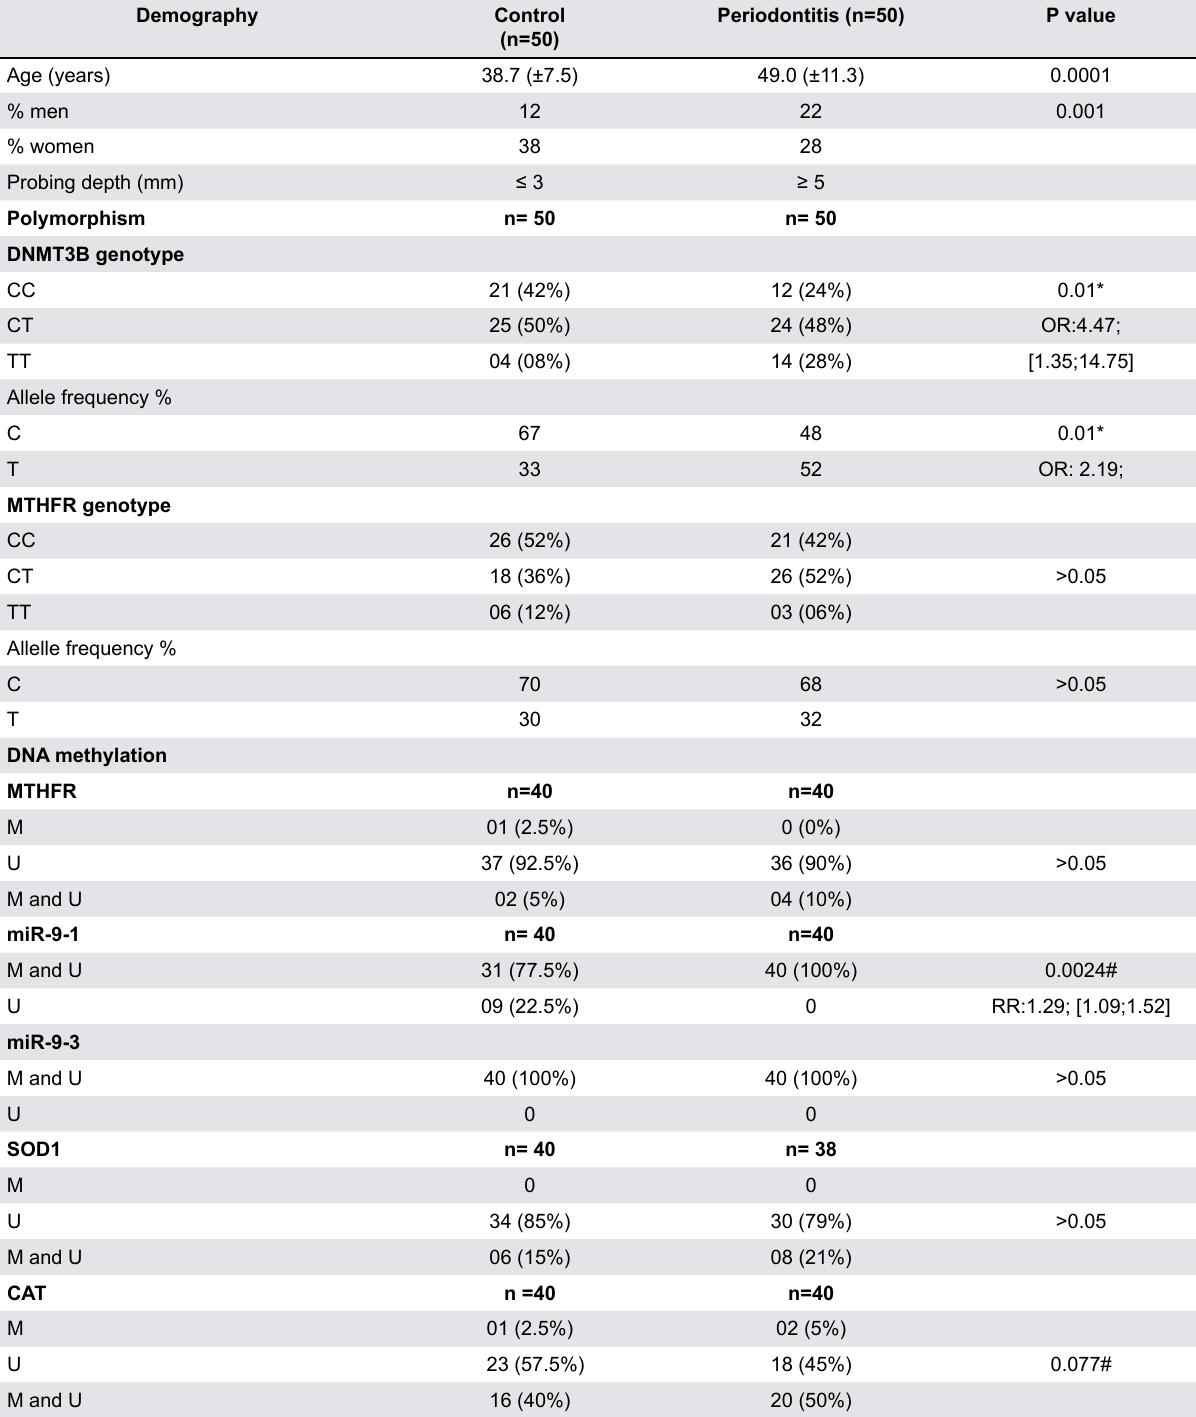
Table 1- Demographic, polymorphism, and DNA methylation